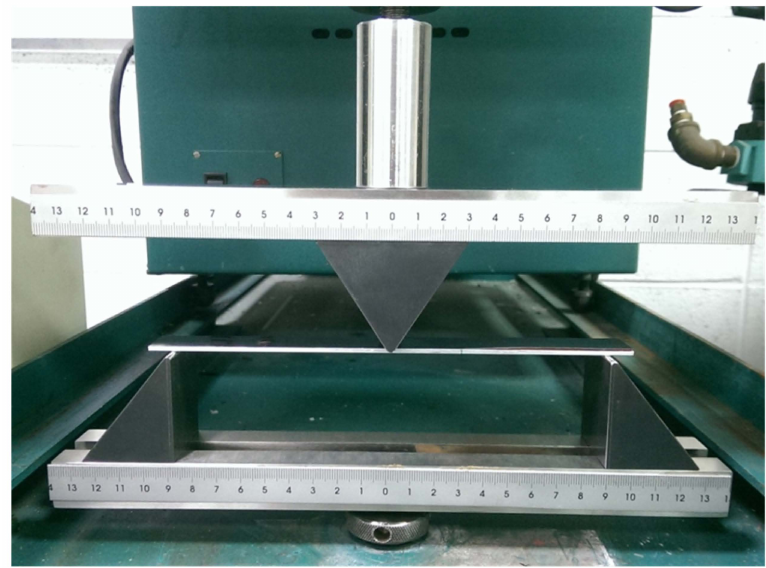
Figure 5. Experimental setup of three-point bending test on an ENF specimen.